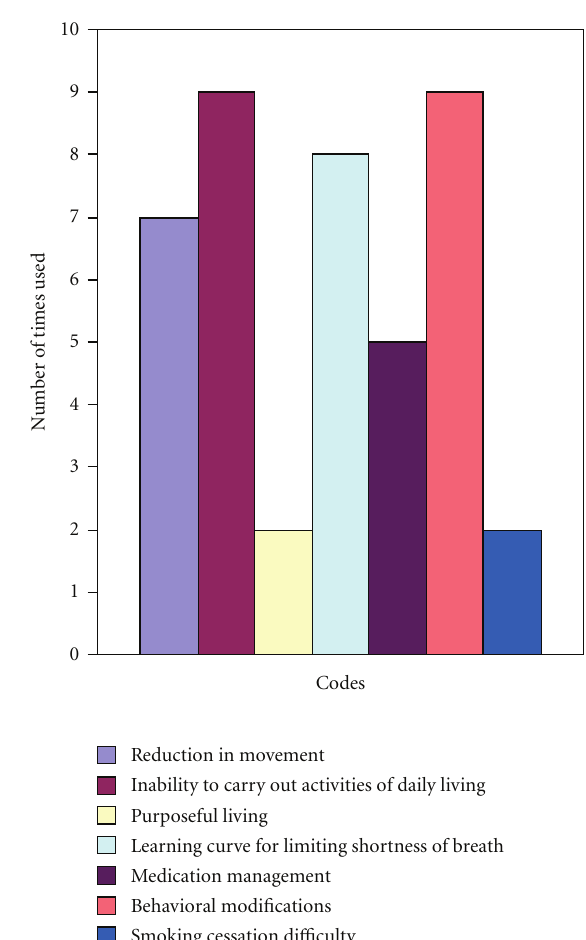
Figure 2: Results from classical content